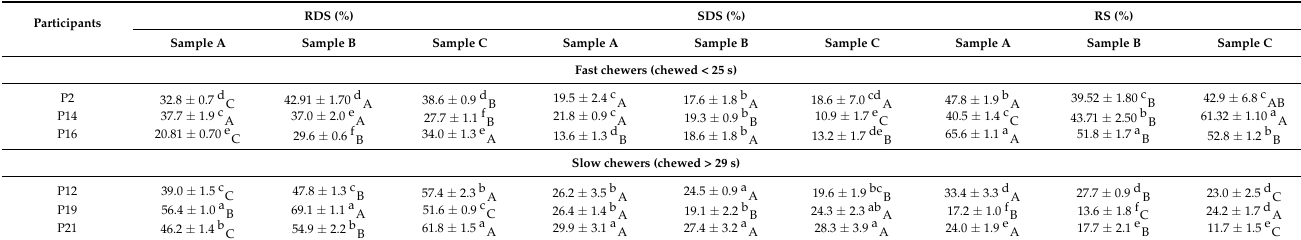
Table 3. Starch fractions of in vivo masticated boluses of the black bean samples (A: PEF and thermally processed without CaCl 2 addition; B: PEF and thermally processed with CaCl 2 addition; and C: No PEF, thermally processed with CaCl 2 ) from selected slow and fast chewers after in vitro small intestinal